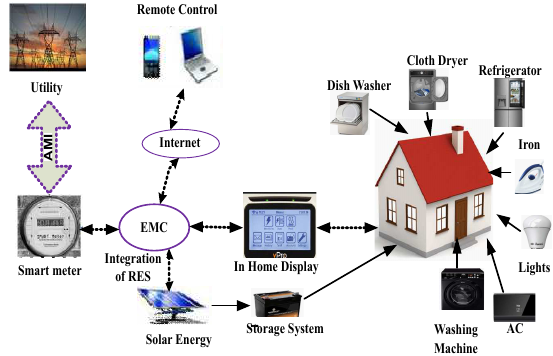
Figure 1. Architecture of energy management system.